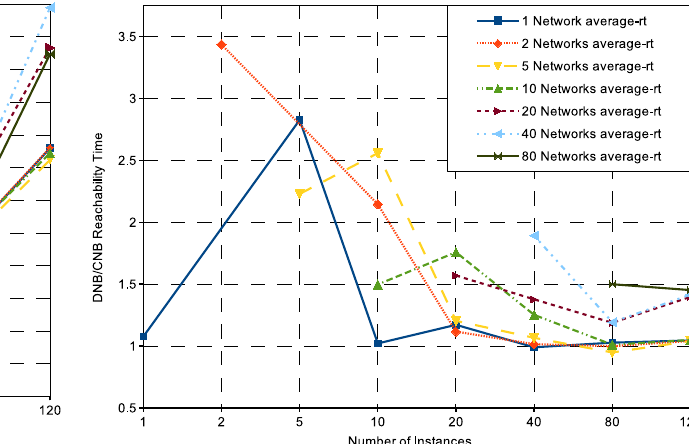
Fig. 4: Average reachability time for DNB Fig. 5: Average reachability time comparison (DNB/CNB)